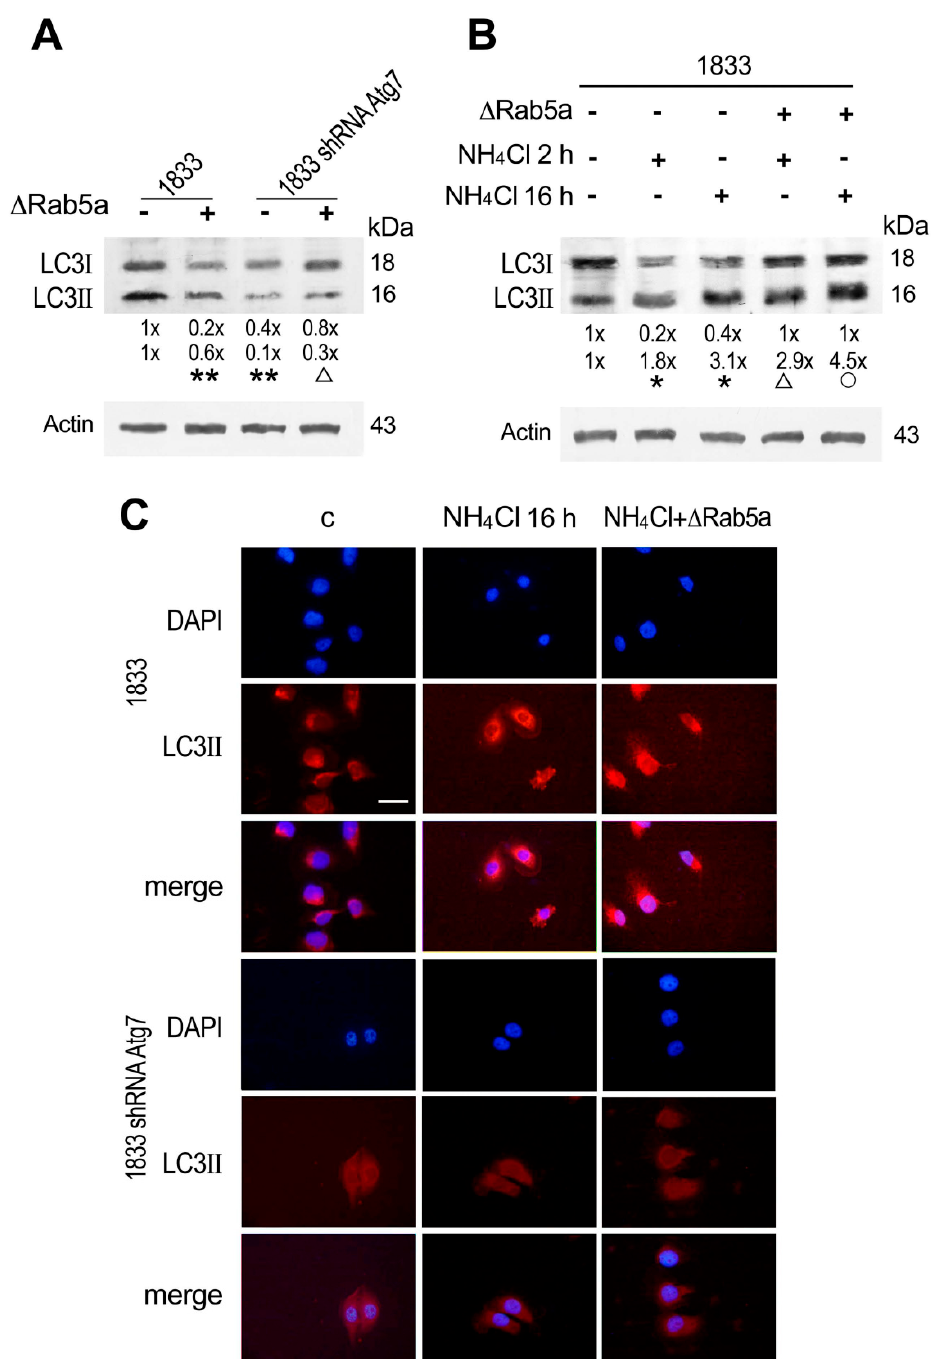
Figure 4. Effect of Δ Rab5a on LC3 forms in 1833 and in 1833-shRNA Atg7 cells. ( A ) Samples of total protein extracts (100 µg) were analysed by Western blot. Actin was used for normalization. The experiments were repeated three times with similar results. ** p < 0.005 versus the first lane; Δ p < 0.05 versus 1833-shRNA Atg7 cells; ( B ) Samples of total protein extracts (100 µg) were analysed by Western blot. Actin was used for normalization. The experiments were repeated three times with similar results. * p < 0.05 versus the first lane; Δ p < 0.05 and ° p < 0.05 versus 1833 cells exposed to NH 4 Cl for 2 and 16 h, respectively; ( C ) 1833 and 1833-shRNA Atg7 cells on coverslips were transfected or not with Δ Rab5a, and were exposed to NH 4 Cl. The immunofluorescence experiment was performed in triplicate. LC3II, red; DAPI, blue. The images were collected at 400× magnification under fluorescence microscope. Size bar = 120 µm.